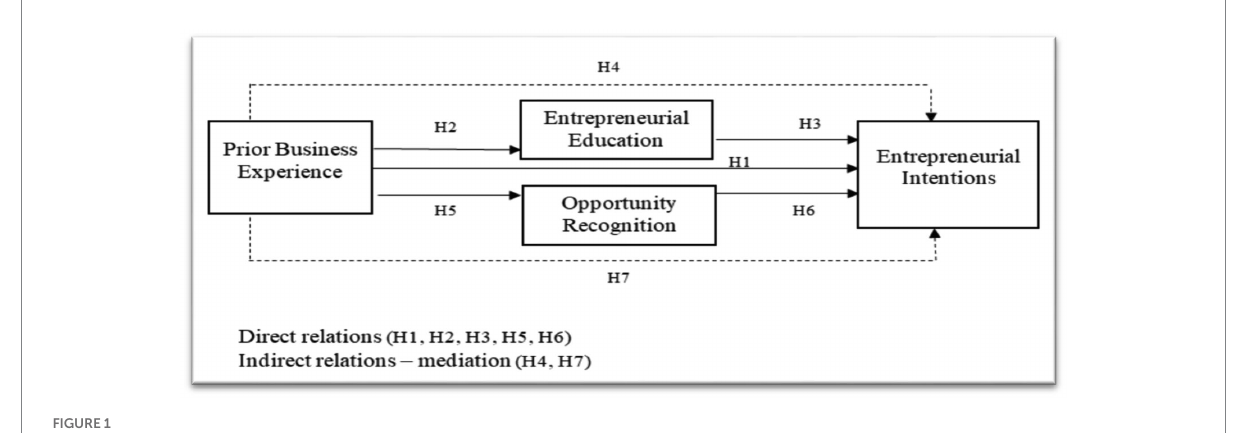
FIGURE 1 Research